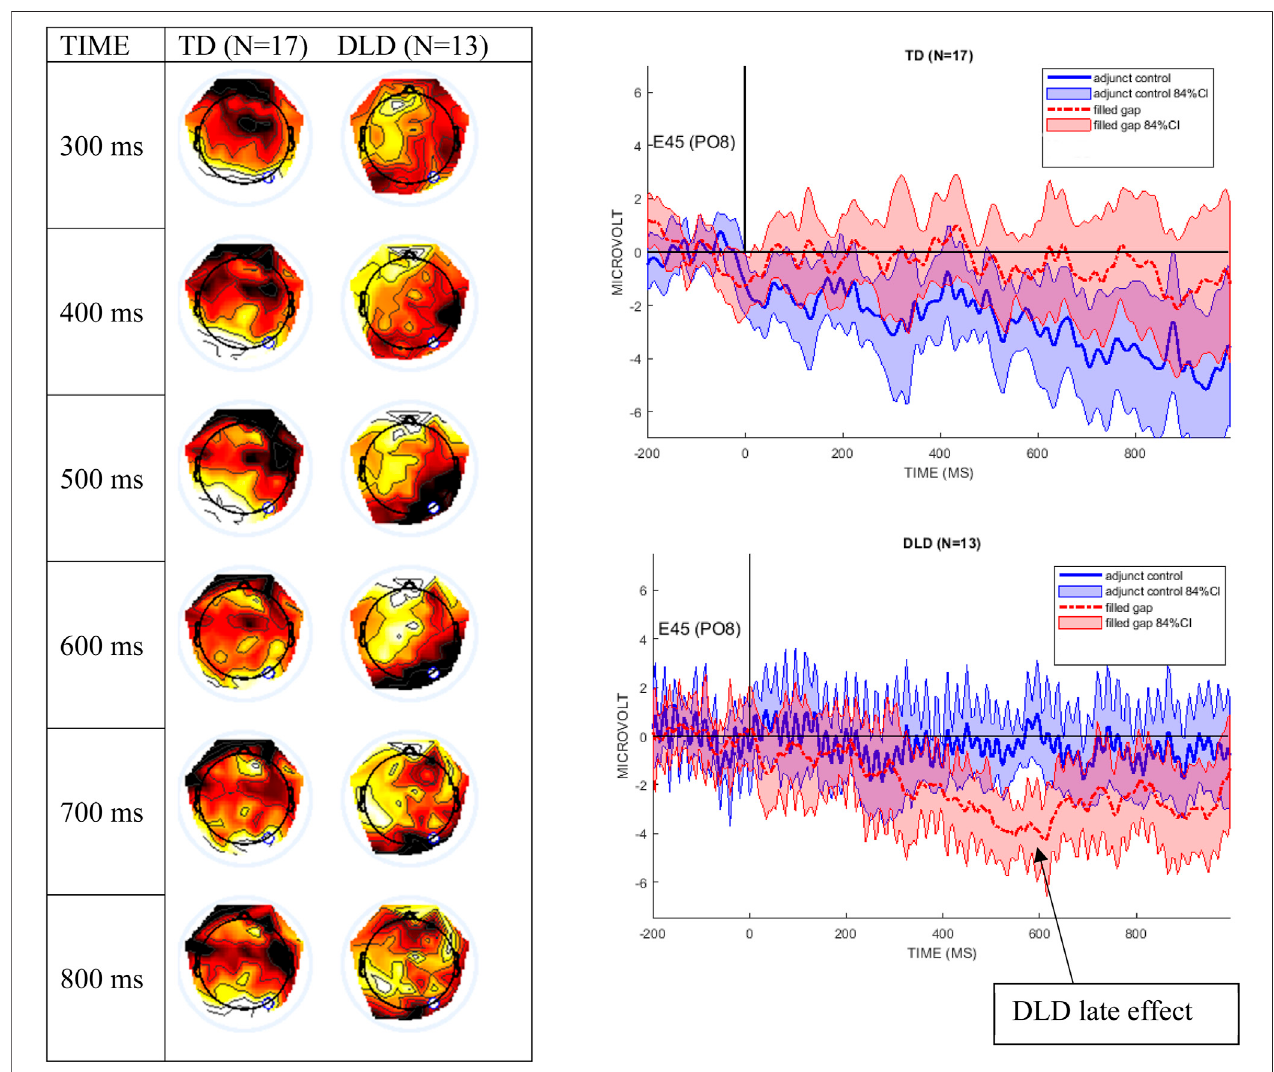
FIGURE5| Theleftpanelshowsdifferencewavetopographicalplotsat100-msincrementsbetween300and800 msfromtheonsetofthe fi lledgapNP,fortheTD controlsandtheDLDgroup.Scaleforcolormin/max: − 2 μ V(darkred)to+2 μ V(white).ThewhitedotiselectrodeE45(PO8).TherightpanelshowselectrodeE45forthe DLD and the TD group, with 85% CI around the fi lled gap (red) vs. the adjunct control (blue) waves.